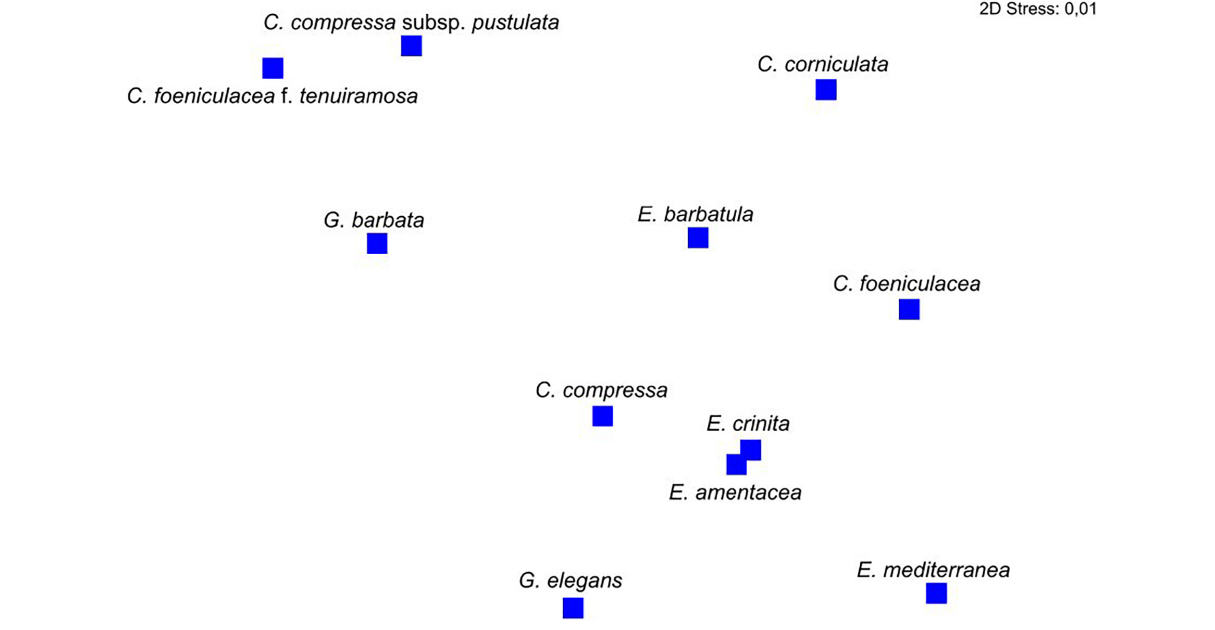
in the Mediterranean (e.g., Fabbrizzi et al., 2020), either singly or in